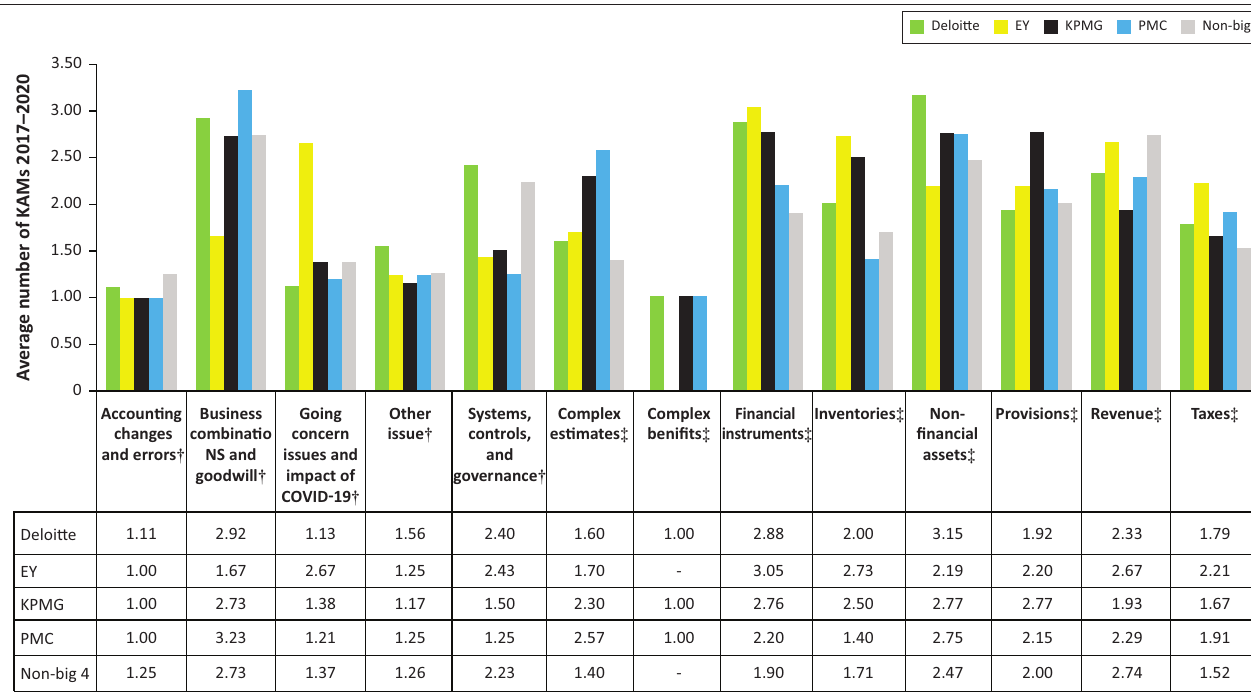
FIGURE 5: Average key audit matters (KAMs) by type and audit